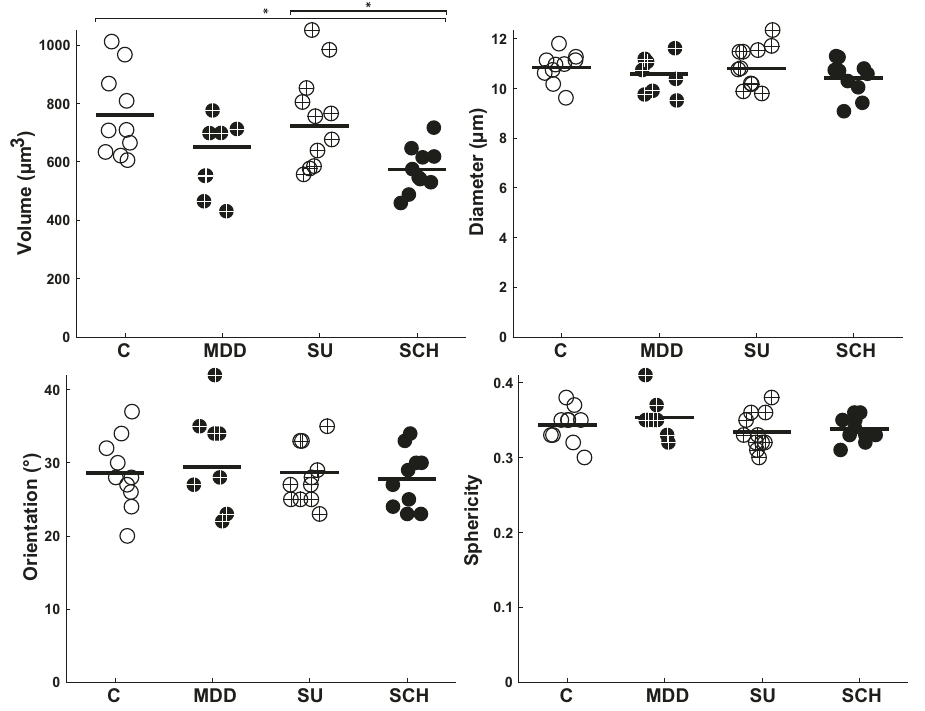
Fig. 3 Morphological results of the 3D-analysis of BA46 in layer III. The estimated volume, diameter, orientation, and sphericity of pyramidal cells in layer III of BA46 between the four groups. Control (C), Major depressive disorder (MDD), Suicide (SU), and Schizophrenia (SCH). ∗ P < 0.05, ∗∗ P < 0.01, ∗∗∗ P <